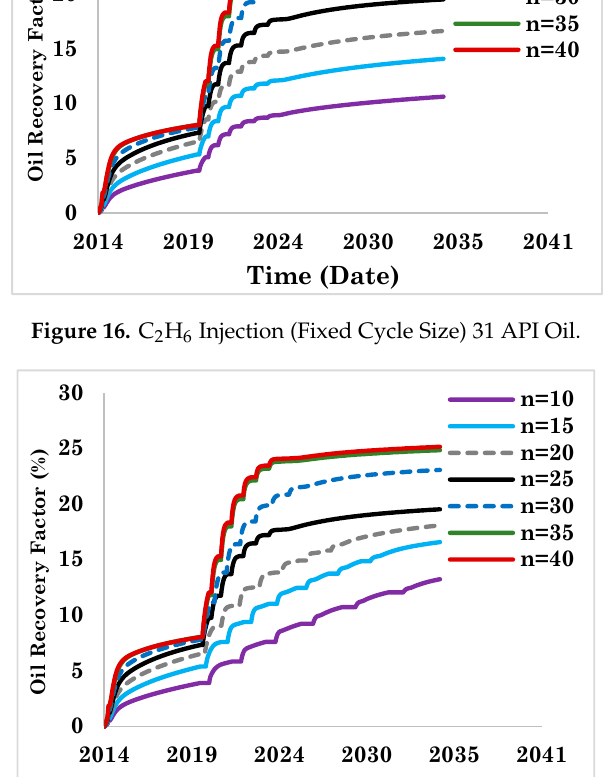
Figure 17. C 2 H 6 Injection (Extended Cycle Size) 31 API Oil